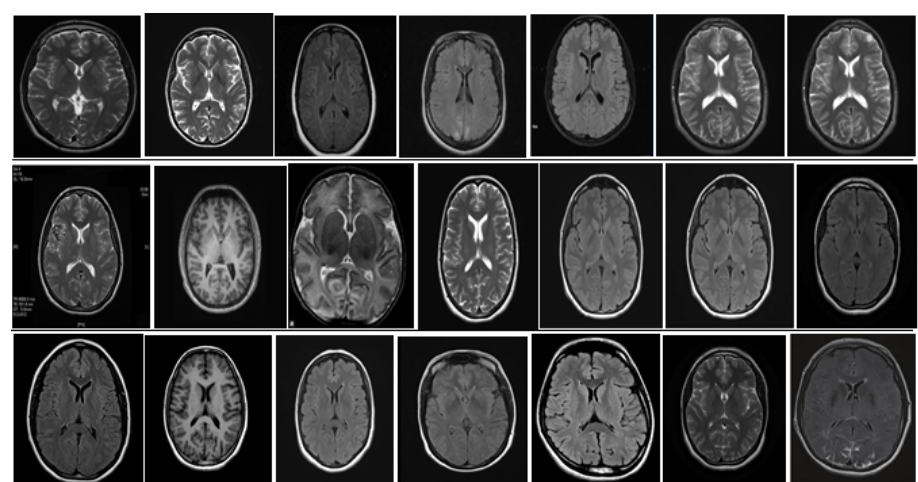
Figure 9. Normal brains.